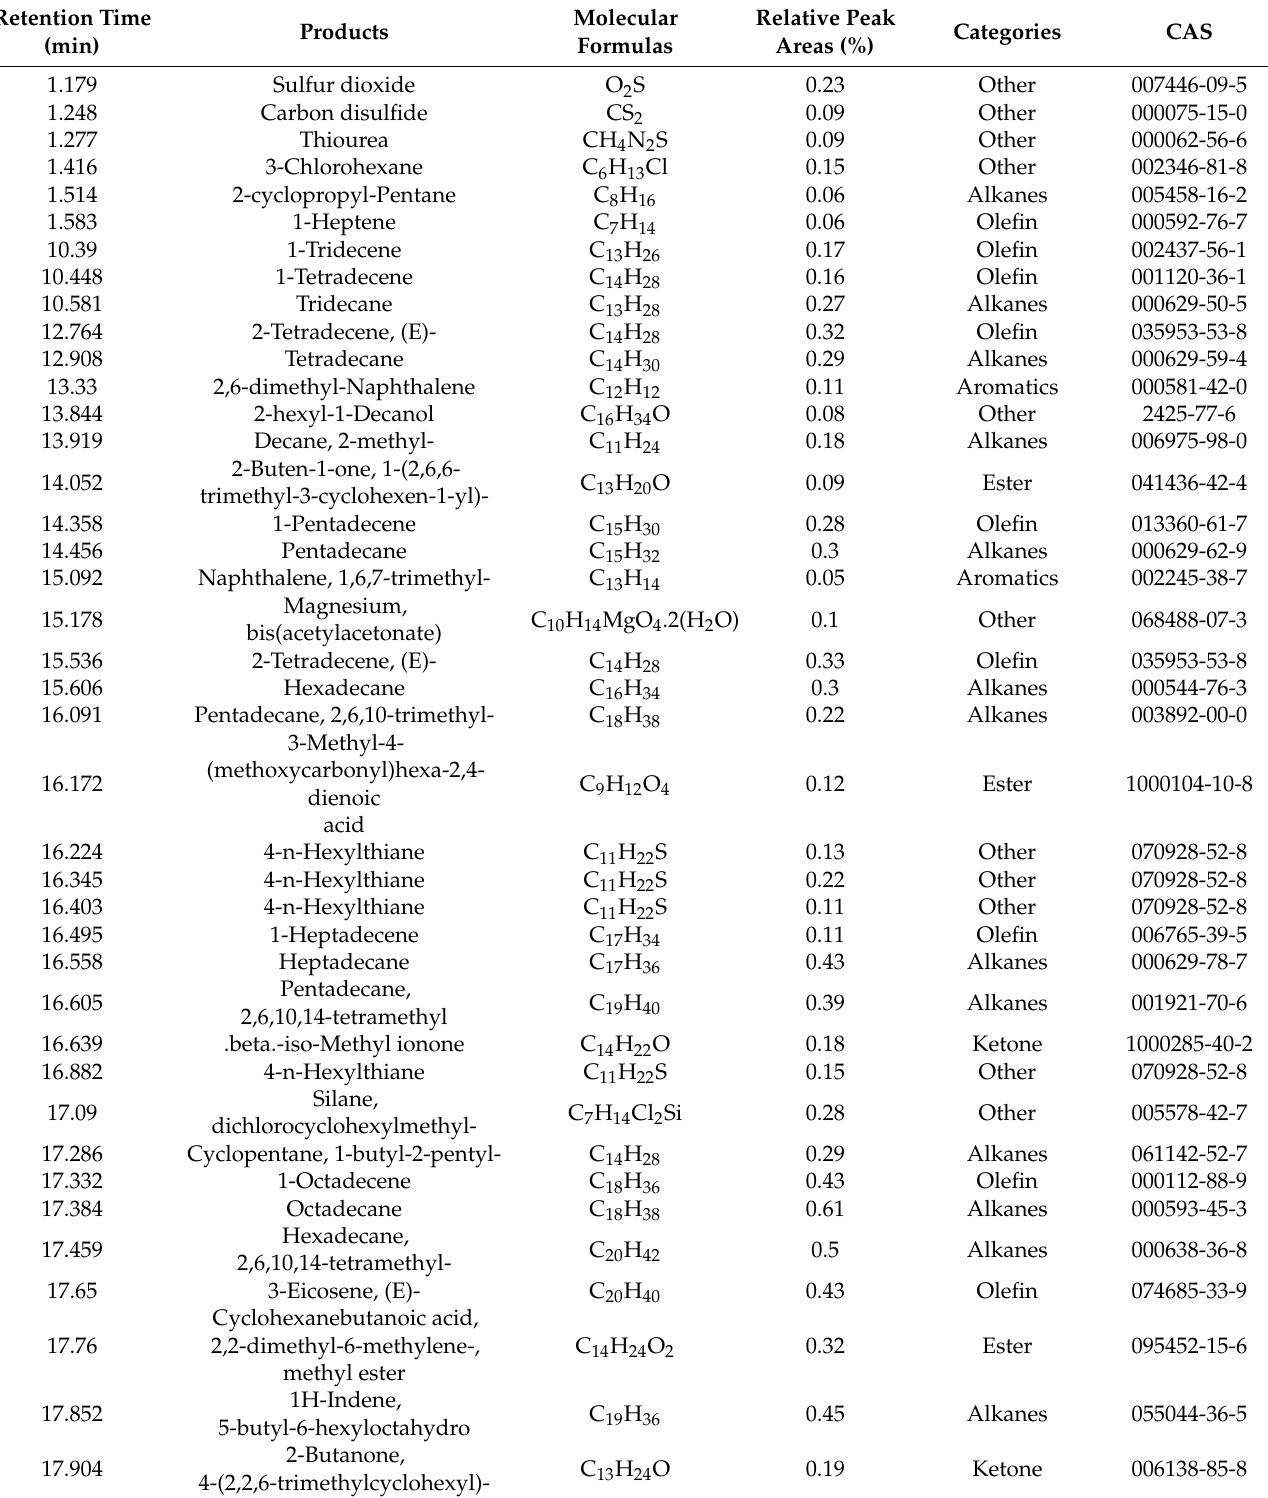
Table A1. Analysis results of organic components of oily